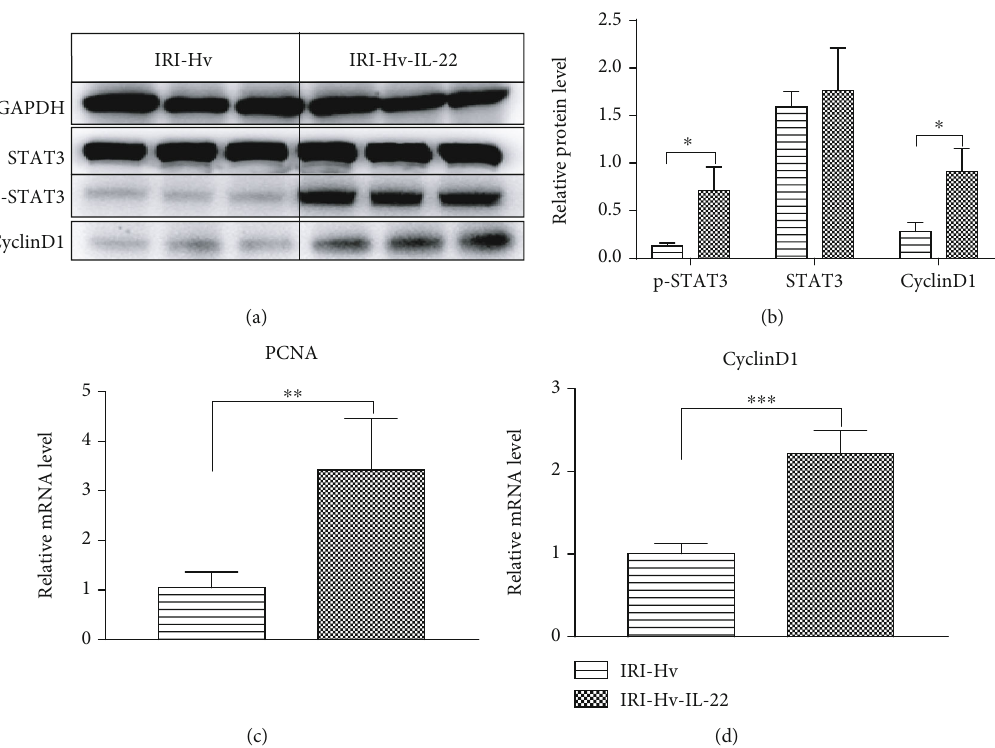
Figure 6: Exogenous IL-22 recombinant protein activates the hepatic STAT3 signaling pathway inhibited by Hv. (a, b) Western blotting results show that the expressions of p-STAT3 and cyclinD1 in the IRI-Hv-IL-22 group were signi fi cantly higher than those in the IRI-Hv group at 6 h. Similarly, we found a signi fi cant di ff erence in the expression of cyclinD1 and PCNA mRNA between the two groups at 6 h by qPCR (c, d) ( n = 4 ‐ 5 , ∗ p < 0 : 05